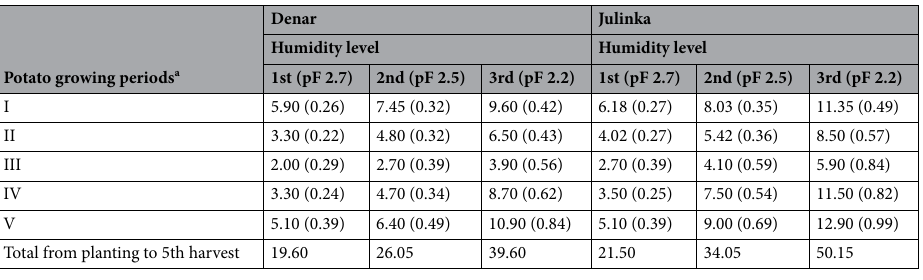
Table 1. Water consumption per pot within potato growing stages (in liters) and average consumption of water per pot (in brackets). a I—from tuber planting to BBCH 40/400, II—from BBCH 40/400 to 52/502, III— from BBCH 52/502 to BBCH 60/600, IV—from BBCH 60/600 to BBCH 69/609, V—from BBCH 69/609 to BBCH